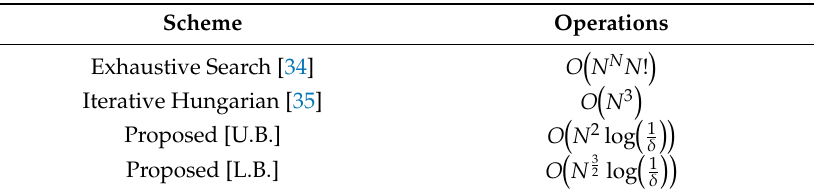
Table 3. Comparison of complexity.